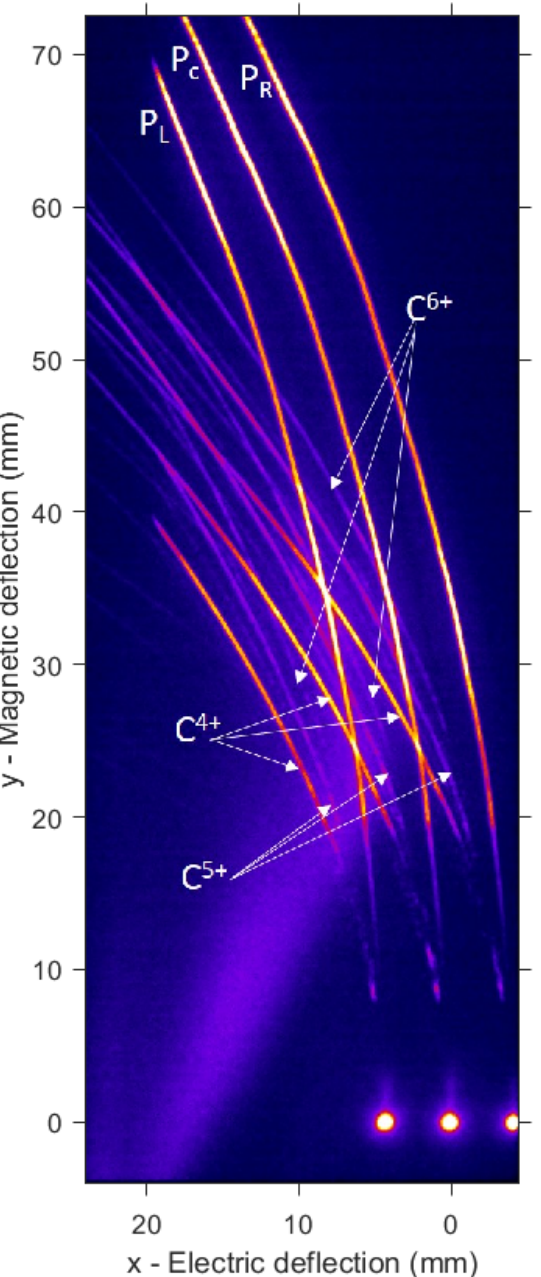
Figure 3. Multi-pinhole Thomson parabola traces obtained from a single laser shot at VEGA 3. The origin of the coordinate system corresponds to the zero-deflection point of the central beamlet. P L , P C , and P R corresponds to the tracks related to the left, central, and right beamlets, respectively. C n + indicates the three n-charged ion traces. The halo at the bottom left corner is originated by a leak of white light from plasma emission, which reaches the MCP through the junction of MCP structure and